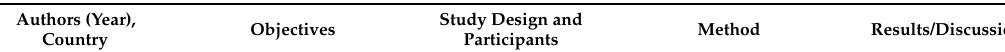
Table 1. Summary of the reviewed studies ( n = 10): Time and